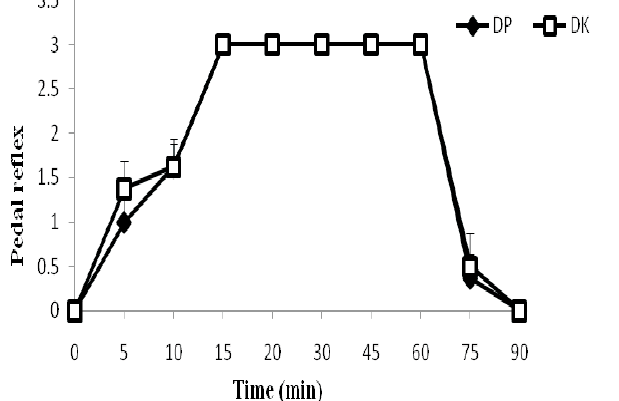
Figure-4: Median±SD values of recovery time, sternal recovery time, standing time and duration of anaesthesia in the animals of groups DP and DK.